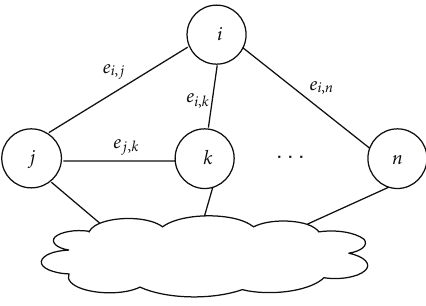
Figure 10: Energy sharing